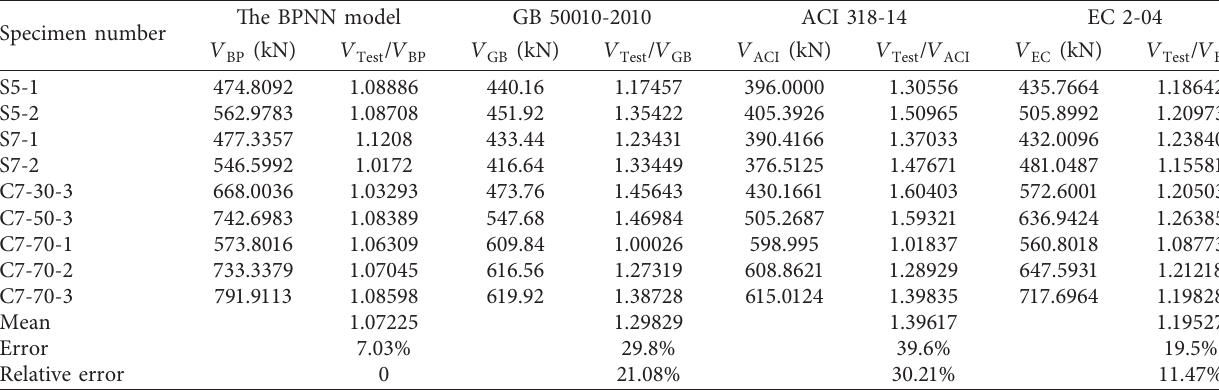
Table 6: Calculated values of the punching capacity of slab-column